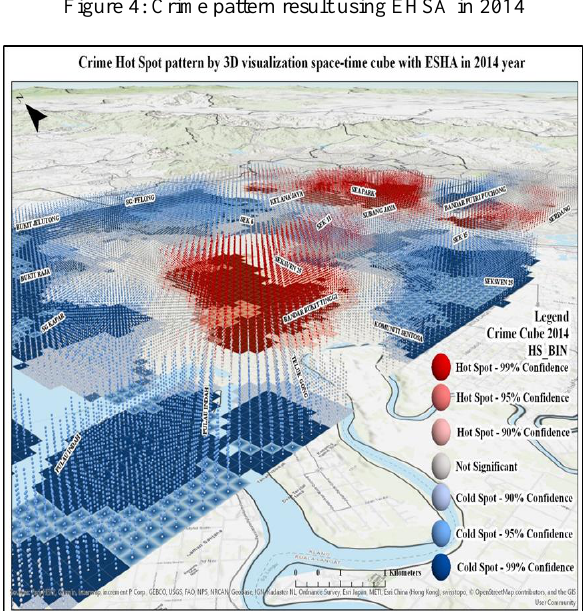
Figure 5: Crime hot spots pattern by 3D visualization in 2014 In 2017 year, the space time cube has aggregated 13,655 points into 9,744 fishnet grid locations over 12-time step intervals.